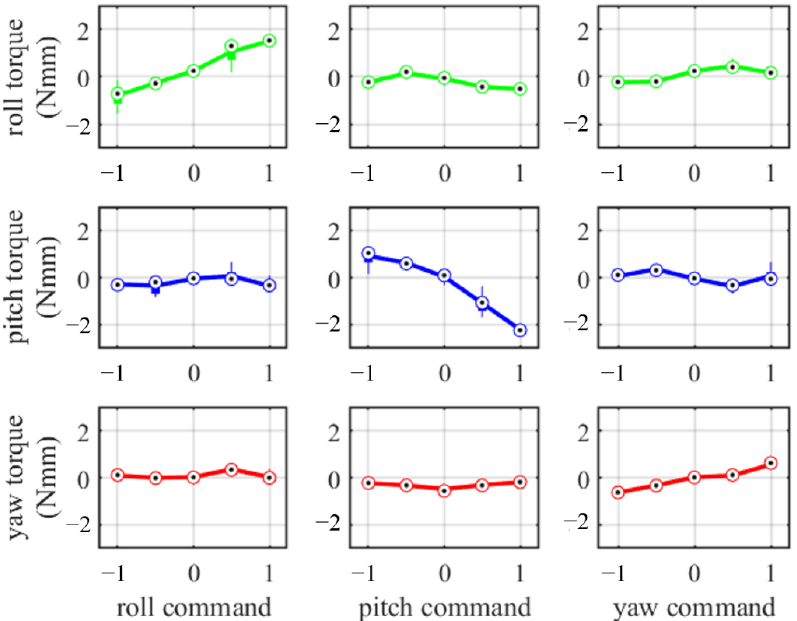
Figure 18. The control torque produced by trailing edge movement. Same control command torque in the longitudinal direction and same type of torque in the transverse direction.